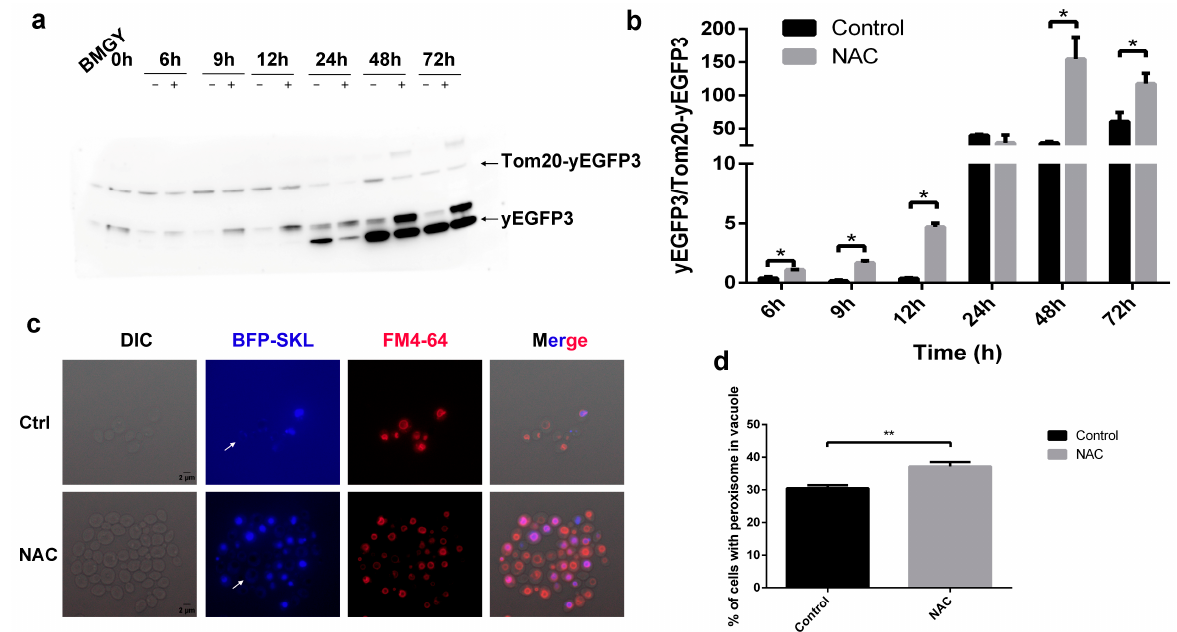
Figure 6. Effect of NAC on mitophagy and pexophagy. ( a ) Western blot analysis of GFP in FTom 20 strain that overexpressed Tom 20-yEGFP3 in F strain. ( b ) The relative amounts of protein bands in Figure 6a were estimated using Image J analysis software. The results presented in the histogram reflect the fold-change in yEGFP3 and Tom 20-yEGFP3. p values were calculated using Student’s two-tailed t -test with p < 0.05 considered statistically significant (Marked with *). Error bars represent means ± standard deviation (SD) (n = 3). ( c ) Peroxisome localization in FBFP-SKL strain. SKL is a peroxisome localization peptide. ( d ) Percent of cells with peroxisome in vacuole. p values were calculated using Student’s two-tailed t -test with p < 0.05 considered statistically signi fi cant (Marked with *), and ** represent extremely signi fi cant di ff erence ( p < 0.01). Error bars represent means ± standard deviation (SD) (n = 3).